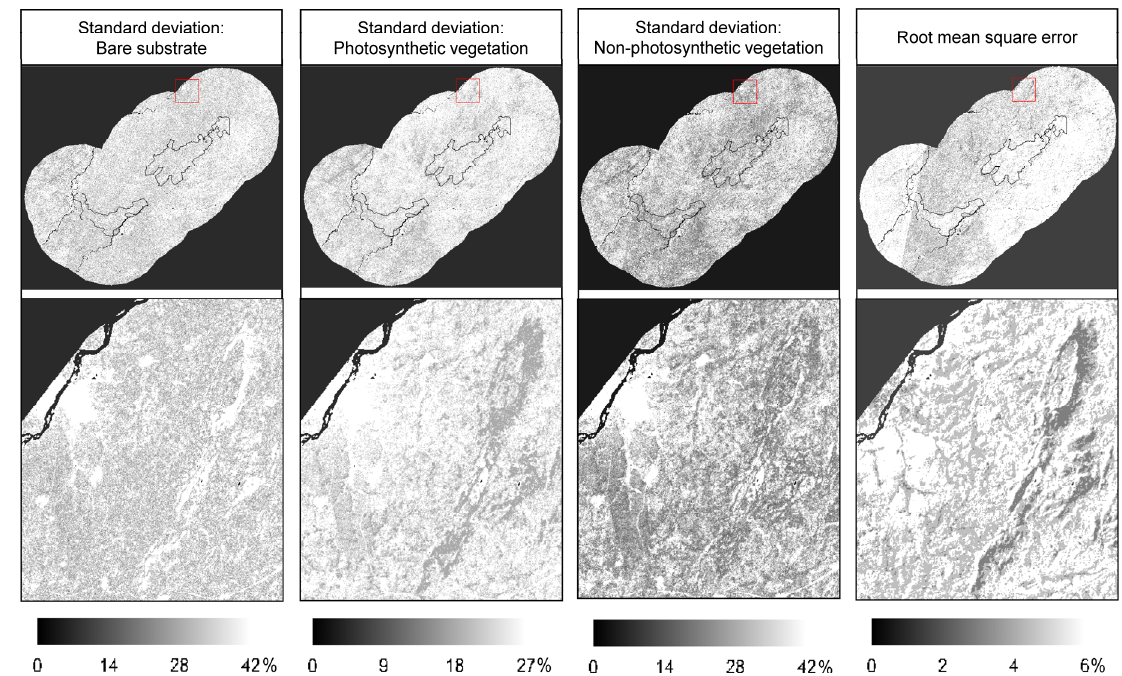
Figure A2. Uncertainty of the bare substrate (S), photosynthetic vegetation (PV), and non-photosynthetic vegetation (NPV) fractional cover outputs from CLASlite alongside total error (root mean square error) of CLASlite’s fractional cover output over the 25 km region surrounding Gola. Error images derive from the 2014 Landsat image over the eastern portion of Gola. Standard deviations of CLASlite’s AutoMCU iterations represent the uncertainties of the S, PV, and NPV outputs. The root mean square error of the modelled versus observed reflectance signatures expresses total map error. Zoomed-in areas of the regions enclosed by red squares in the top row of panels appear in the bottom row of panels and represent the same palm plantation depicted in the top row of Figures 1 and 2. The Gola National Park boundary is outlined in black. Table A3. Contingency matrix assessing the accuracy of the land-classification map of Gola and its surrounding 25 km region in early 2001 derived from supervised classification in ENVI. The three truth classes (in rows) are compared pair-wise with the three land-cover classes of the classification image (in columns). Values in the “Truth Class” rows represent percentage of total pixels in the truth class classified as a given land-cover type on the derived land-cover maps, with 2960 total pixels identified in the mature forest truth class, 2522 total pixels in the other vegetation class, and 2776 total pixels in the non-vegetation truth class. All accuracy values are presented as percentages. Kappa coefficient is reported ± one standard